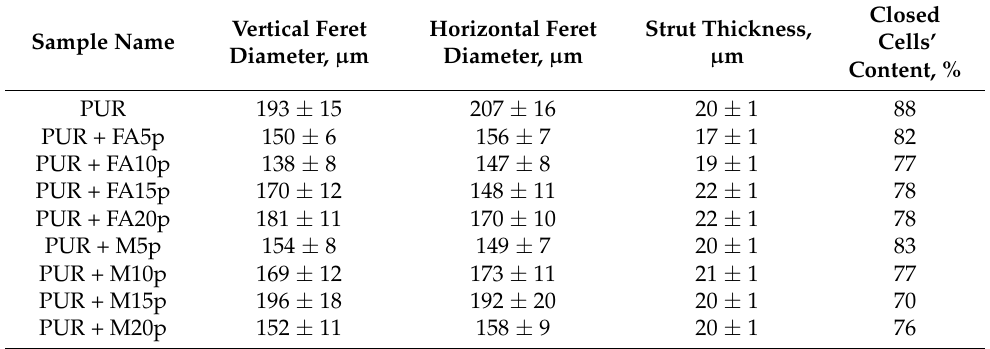
Figure 4. The performed analysis pointed out that the addition of both types of filler did not disrupt the cellular structure of the PUR matrix; however, a decrease in closed cells’ content was observed, reaching approx. cells’ content was observed, reaching approx. 84%.